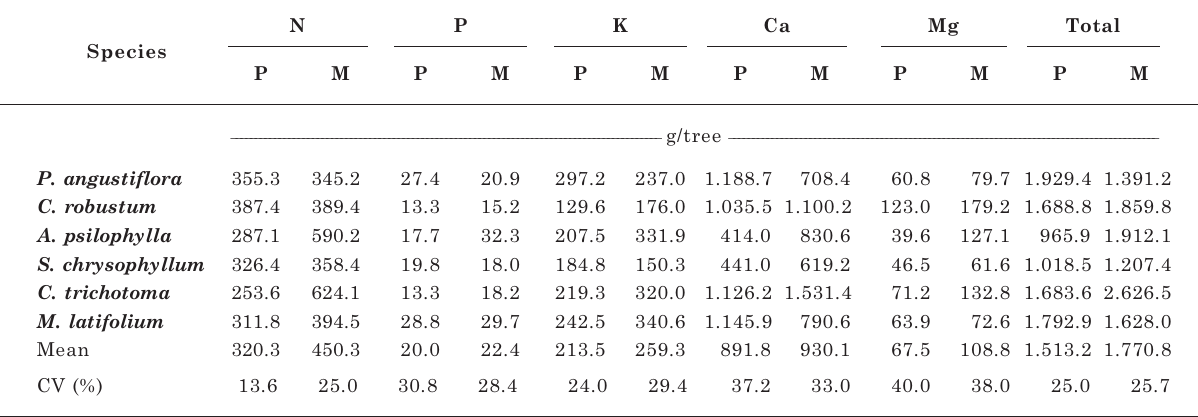
Table 3. Nutrient accumulation in the above-ground biomass of native forest species in pure (P) and mixed (M)